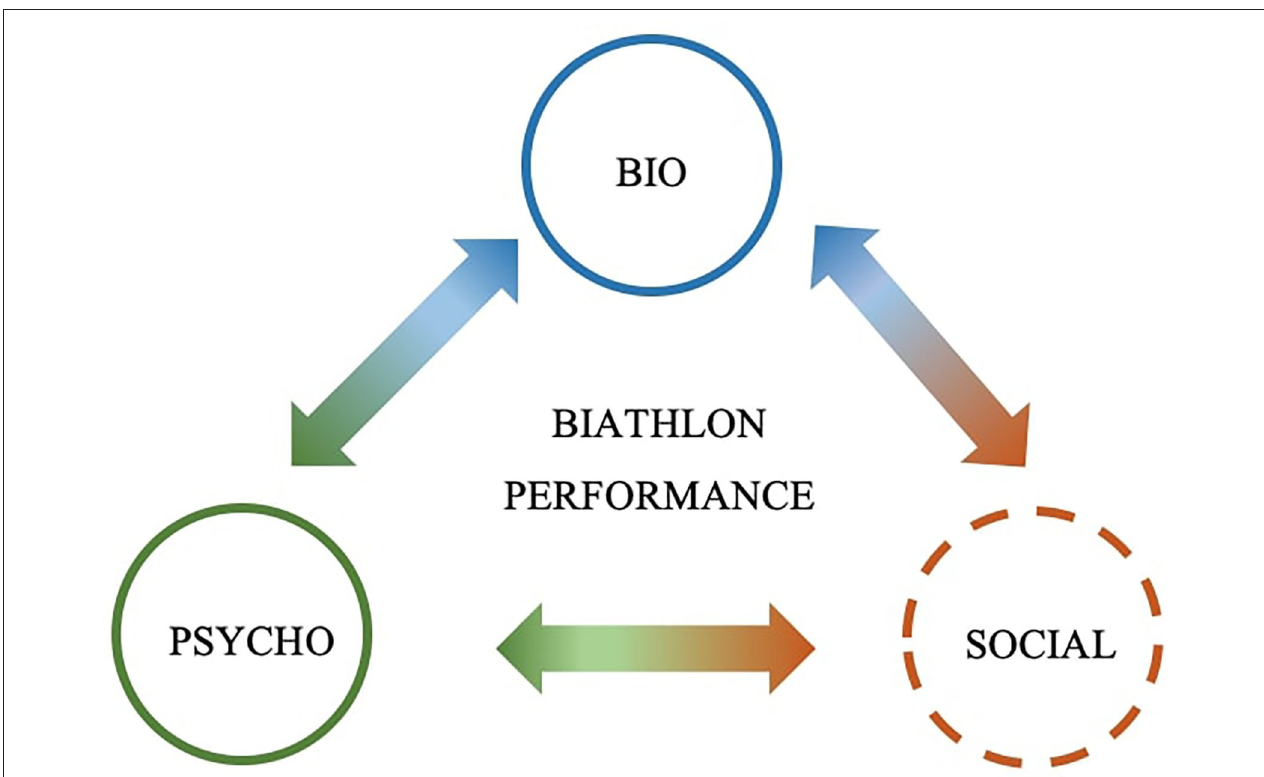
FIGURE 1 | A biopsychosocial framework of biathlon